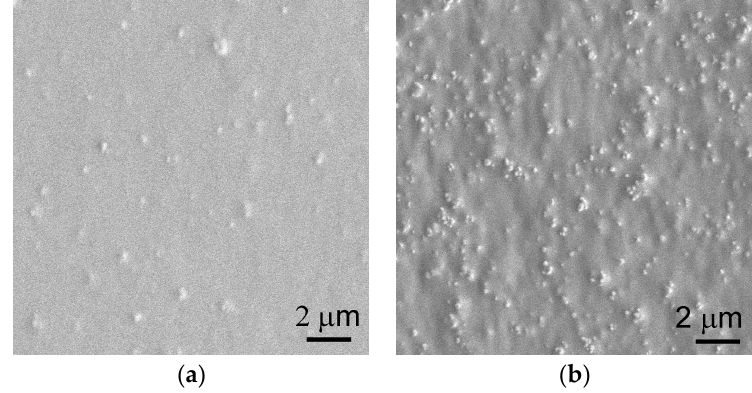
Figure 1. Surface morphologies of PP/TiO 2 composite films with the TiO 2 content of ( a ) 10 wt % and ( b ) 40 wt %.